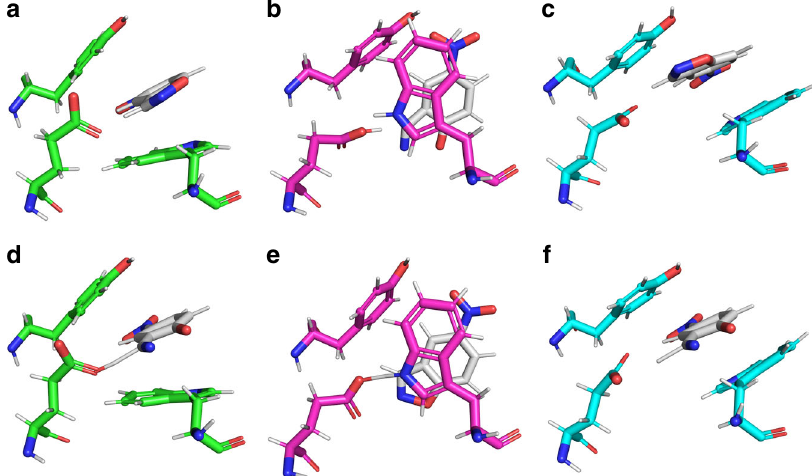
Fig. 4 Snapshots of three different binding modes from computer simulations. A comparison of representative structures of the equilibrated a − c Michaelis complexes and d − f transition state structures for the Kemp elimination of 5-nitrobenzisoxazole catalyzed by ( a , d , green sticks) R7 with Trp50 in conformation A ( b , e , pink sticks) R7-2 with Trp50 in conformation B, and ( c , f , cyan sticks) R7-2 with Trp50 in conformation C. This fi gure highlights the shift in substrate position and key interacting residues upon rotation of the Trp50 side chain. The snapshots shown here correspond to the top ranked cluster obtained by RMSD clustering of the EVB simulations, as described in the Methods